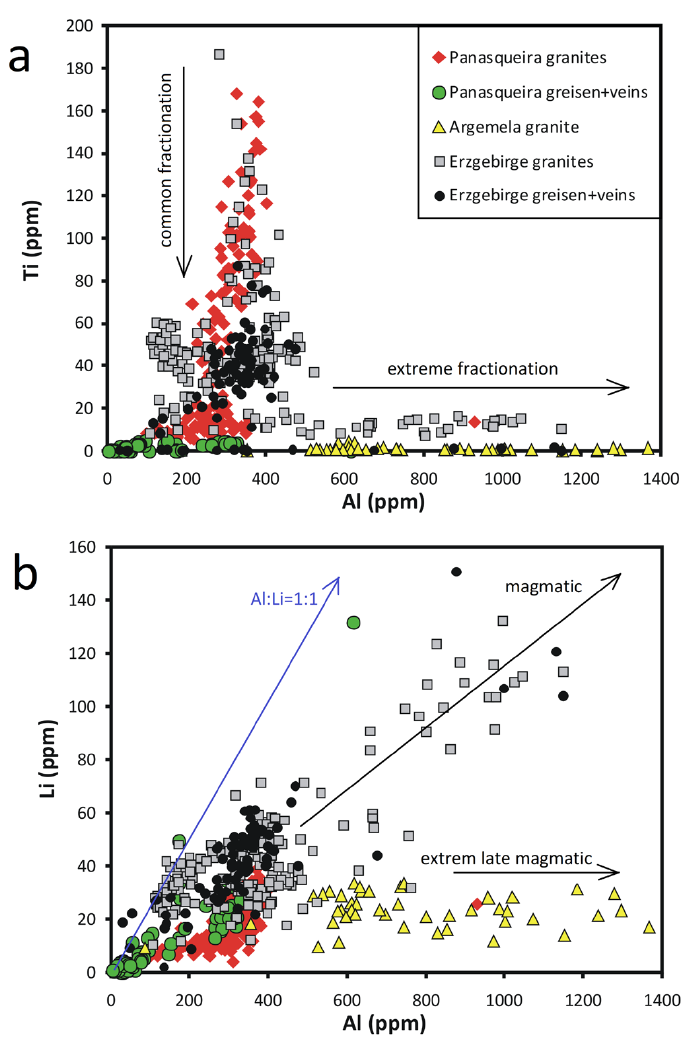
Figure 18. A comparison of trace elements in quartz from Panasqueira with those in quartz from Argemela [26] and the Erzgebirge (authors’ data): ( a ) Al vs. Ti; ( b ) Al vs. Li.